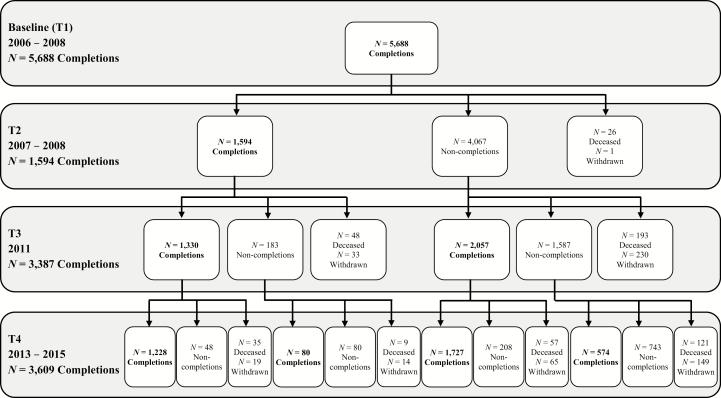
Study sample flow.